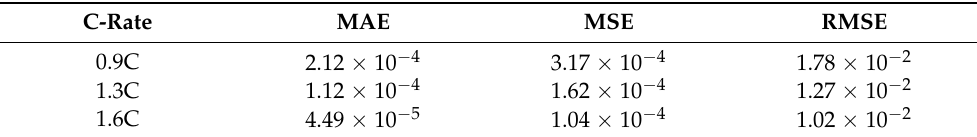
Table 5. FNN degradation model performance based on MAE, MSE, and RMSE values at various discharge rates: 0.9C, 1.3C, and 1.6C.